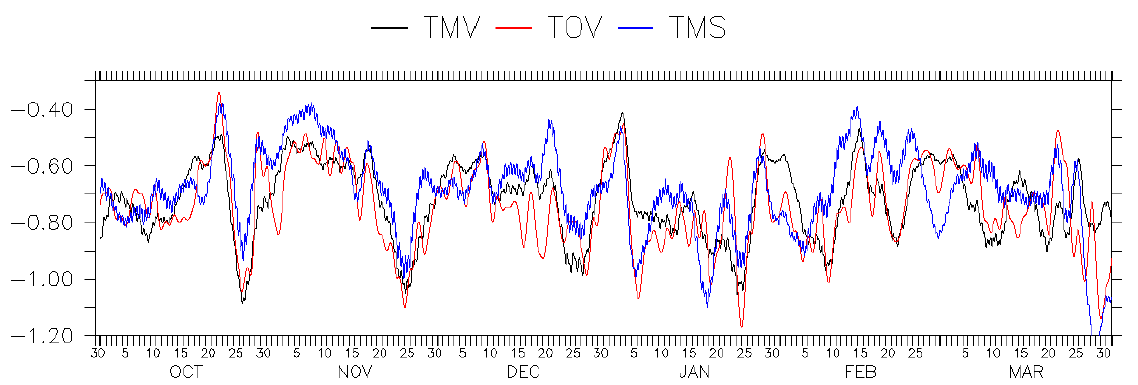
Fig. 5. Transports (outflow) in Sverdrup at the Strait of Gibraltar for TOV (transport observation velocity; the interface used to separate the inflow from the outflow is defined as the time-dependent depth of the surface of zero low-pass frequency velocity), TMV (transport model velocity) and TMS (transport model salinity; the outflow transport is computed using the commonly used 37.25 isohaline).